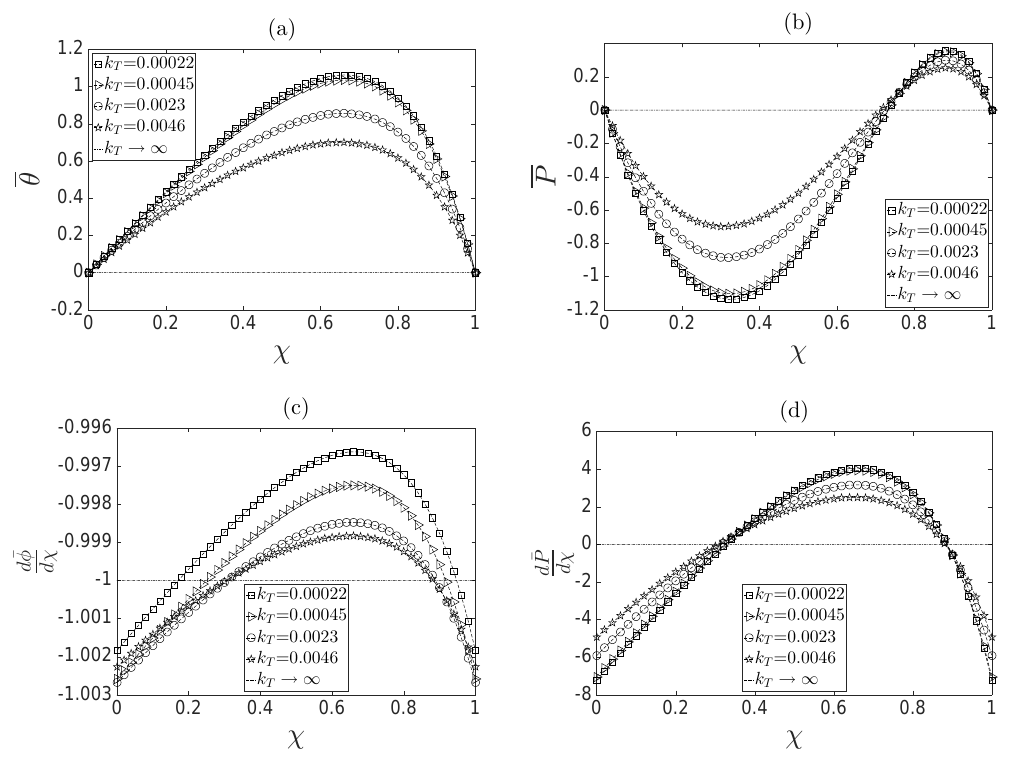
Figure 2. Influence of the dimensionless parameter K T on the dimensionless ( a ) temperature, ( b ) pressure, ( c ) electric field and ( d ) pressure gradient.